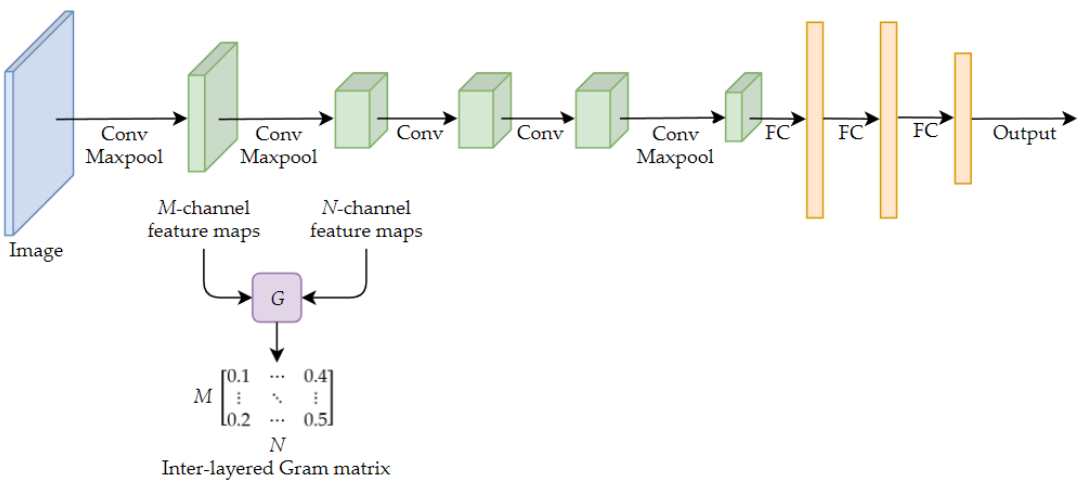
Figure 2. Illustration of the calculation for the inter-layered Gram matrix.